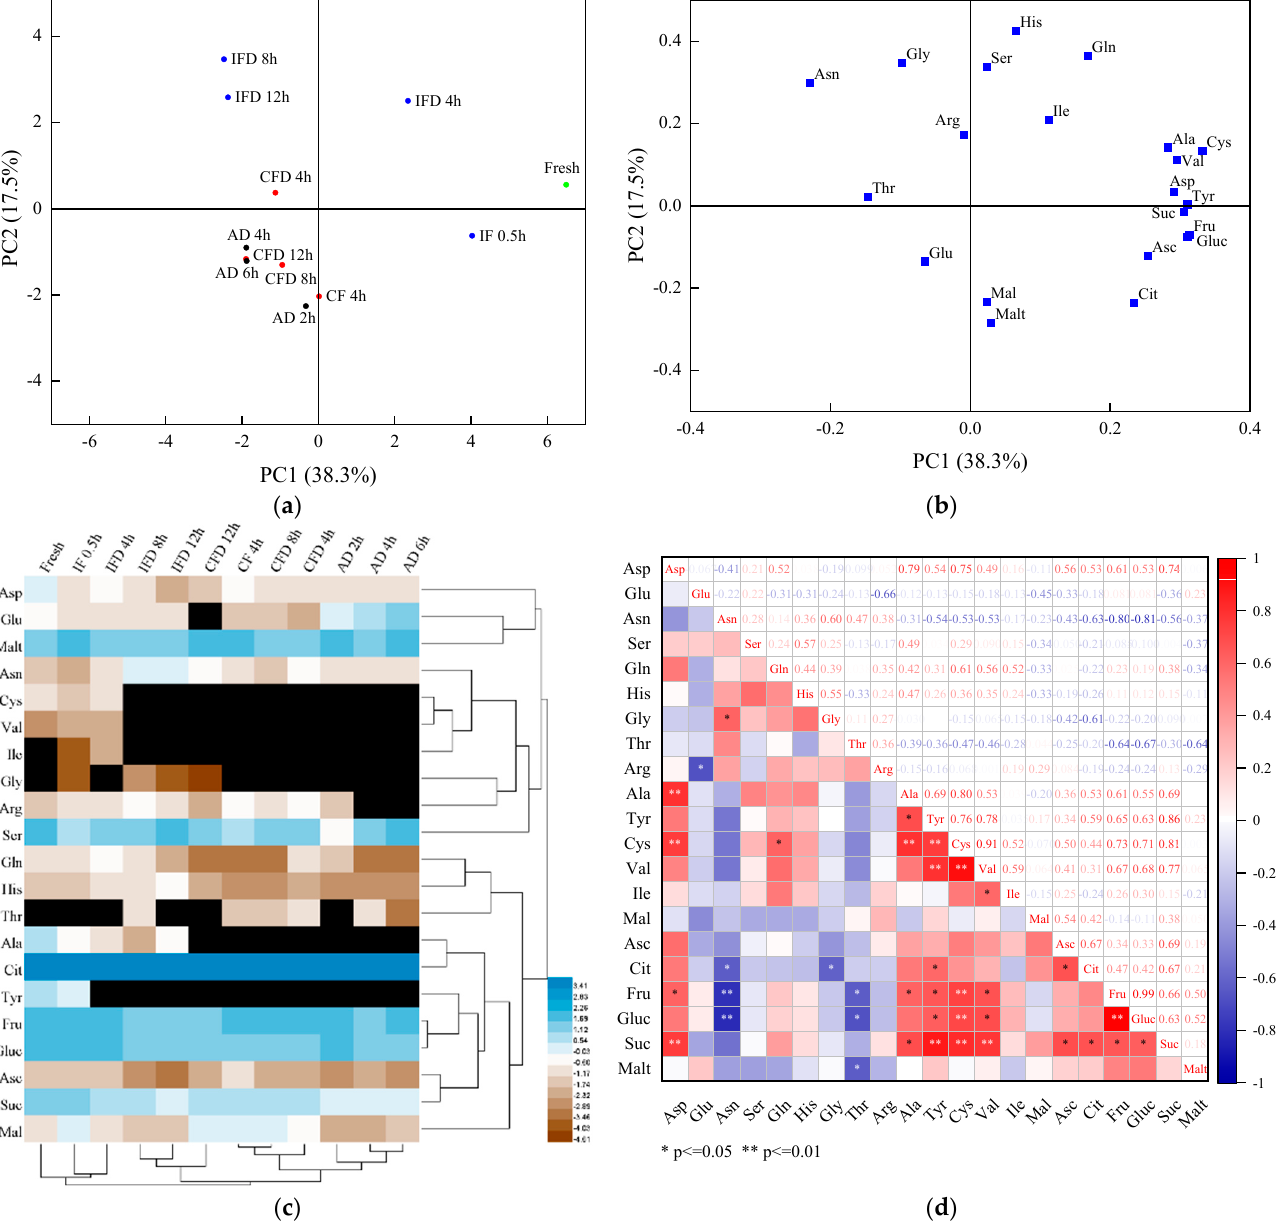
Figure 3. Principal component analysis, hierarchical cluster analysis, and Pearson’s correlation analysis based on the contents of nonvolatile flavor compounds in the samples during the drying processes. The abbreviated words represent the nonvolatile flavor compounds in Table 2. ( a ): Score plot of principal component analysis of the different drying stages; ( b ): Score plot of principal component analysis of the nonvolatile flavor compounds; ( c ): Heatmap of hierarchical cluster analysis; ( d ): Heatmap of Pearson’s correlation analysis.